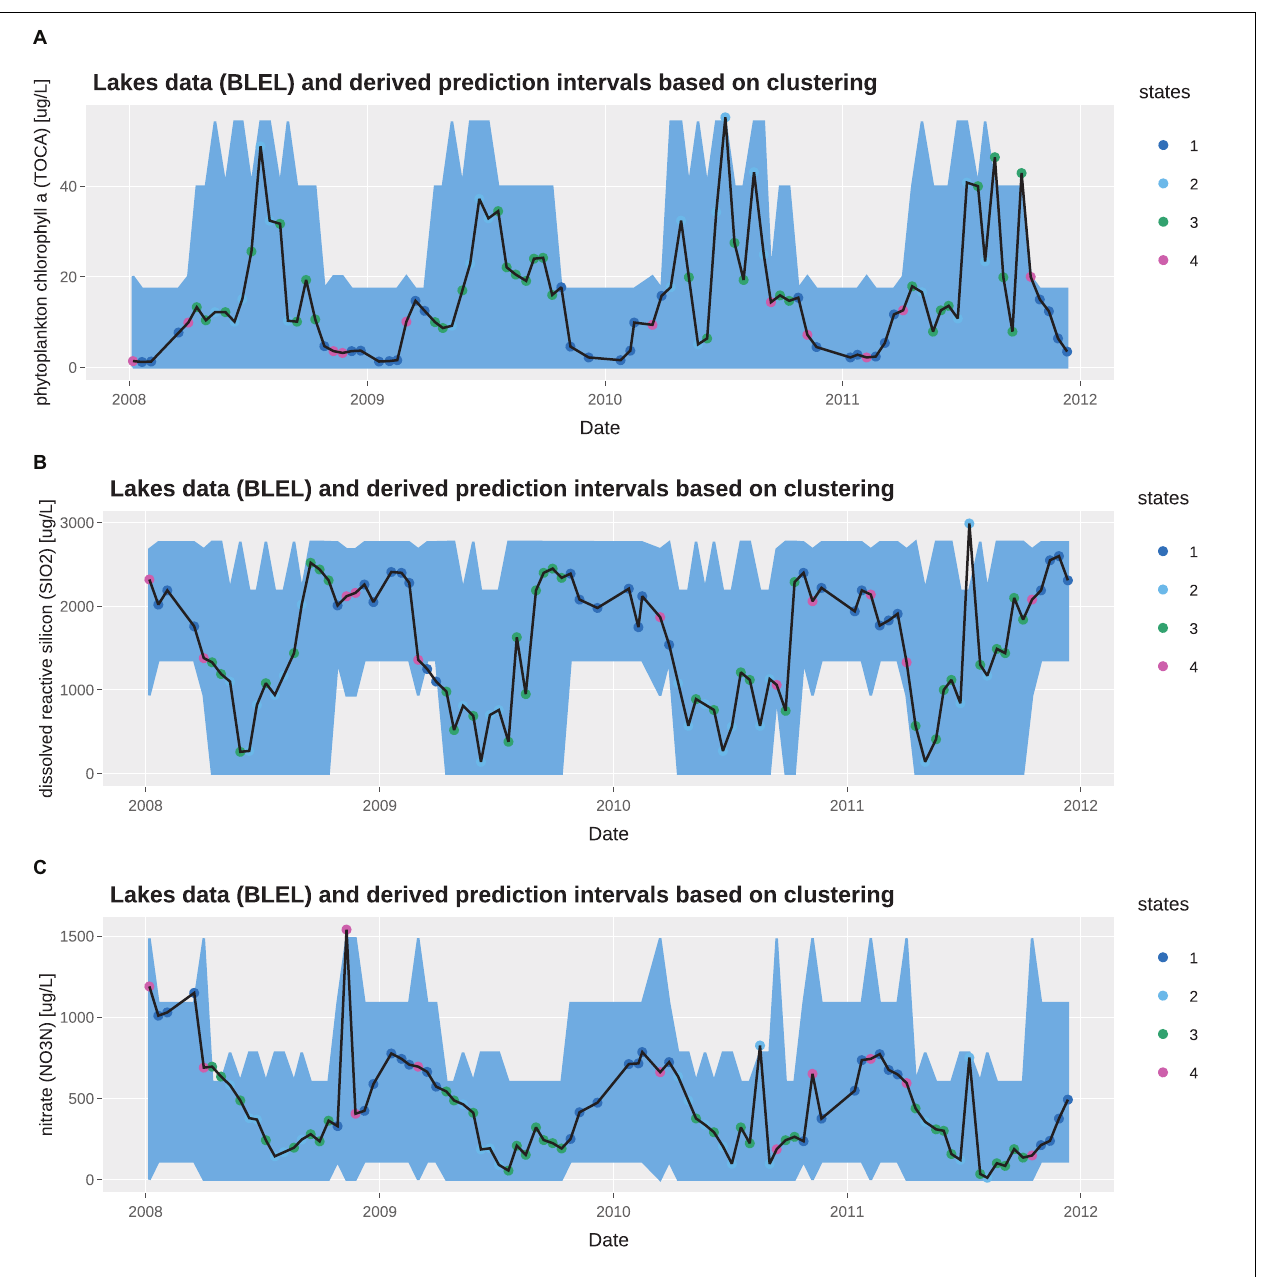
FIGURE 6 | Observed concentration and 95% prediction intervals at Blelham Tarn: (A ) total chlorophyll a [ µ g/L], (B) dissolved reactive silicon [ µ g/L], (C) nitrate [ µ g/L].